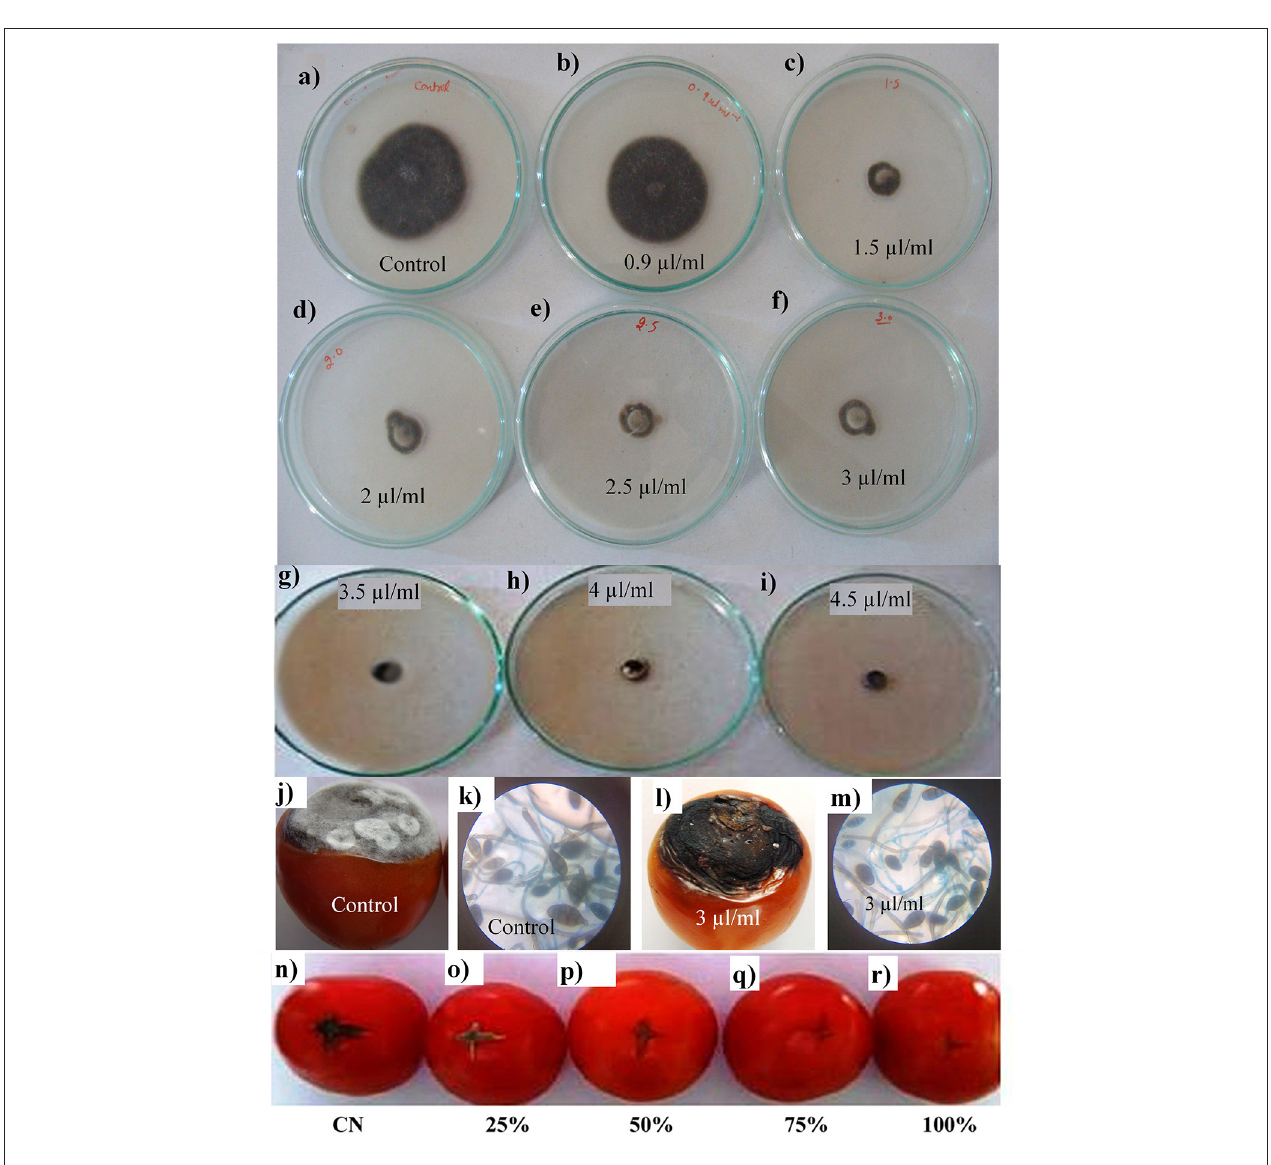
FIGURE 2 | Effects of Z. armatum DC. EO applied at 0.9, 1.5, 2, 2.5, 3, 3.5, 4, and 4.5 µ l/ml concentrations on percent mycelial inhibition of A. alternata isolated from infected tomato fruits (a–i) . Effects of Z . armatum EO applied at 3 µ l/ml concentration show significant inhibition of A . alternata growth compared to control fruits